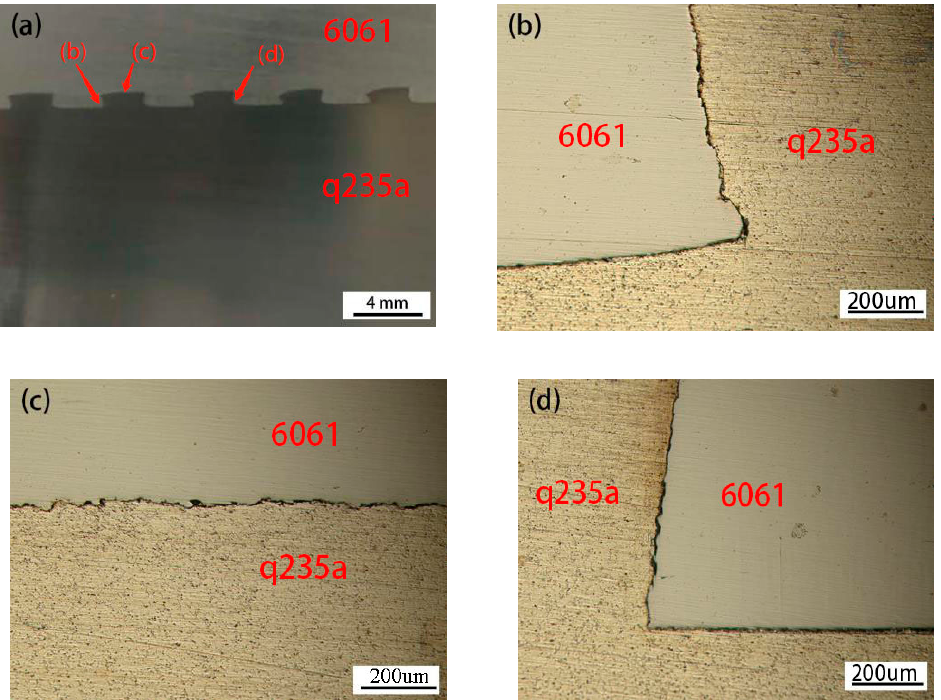
Figure 4. The different metallographic observation structure of groove hot casting plus explosion compression bonding (HCECB) composite plates: ( a ) Metallographic observation location map; ( b ) Bottom and side of dovetail groove; ( c ) the upper surface; ( d ) side and Bottom of dovetail groove.